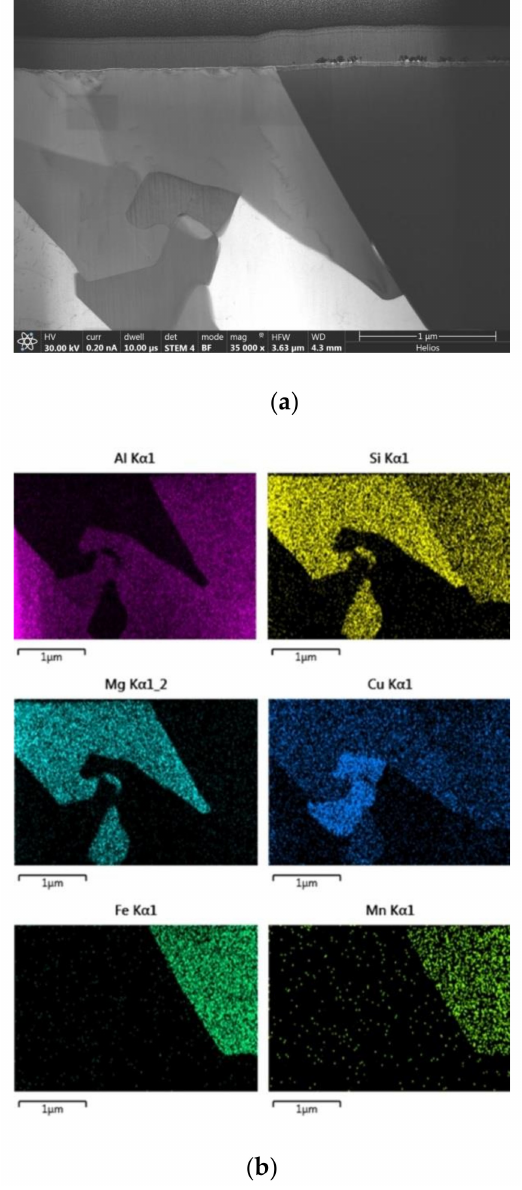
Figure 4. EDS mapping analysis of AlSi7MgCu alloy: ( a ) STEM image [41], ( b ) corresponding EDS elemental maps of Al, Si, Mg [41], Cu [41], Fe [41], and Mn [41]. (Copyright 2019 by The Minerals, Metals & Materials Society. Used with